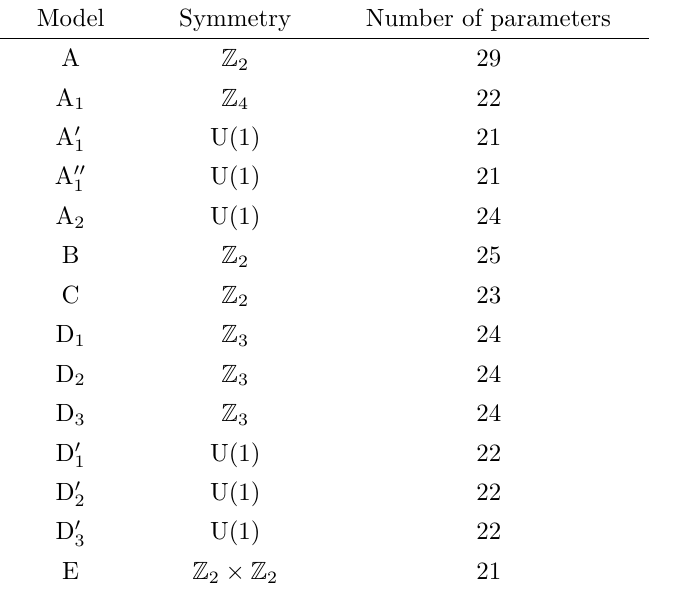
Table 1 . The models listed in appendix A and their associated symmetry groups and numbers of parameters. For details about the parametrization, see section